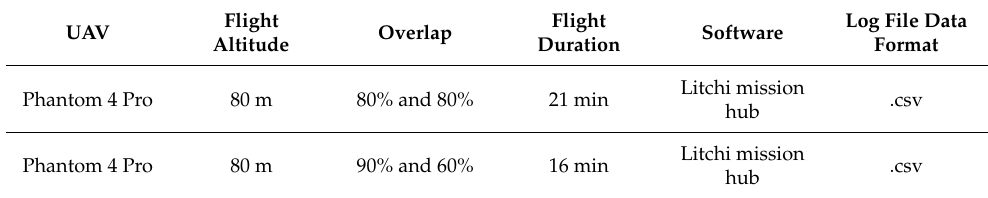
Table 4. Flight details for Vrissa